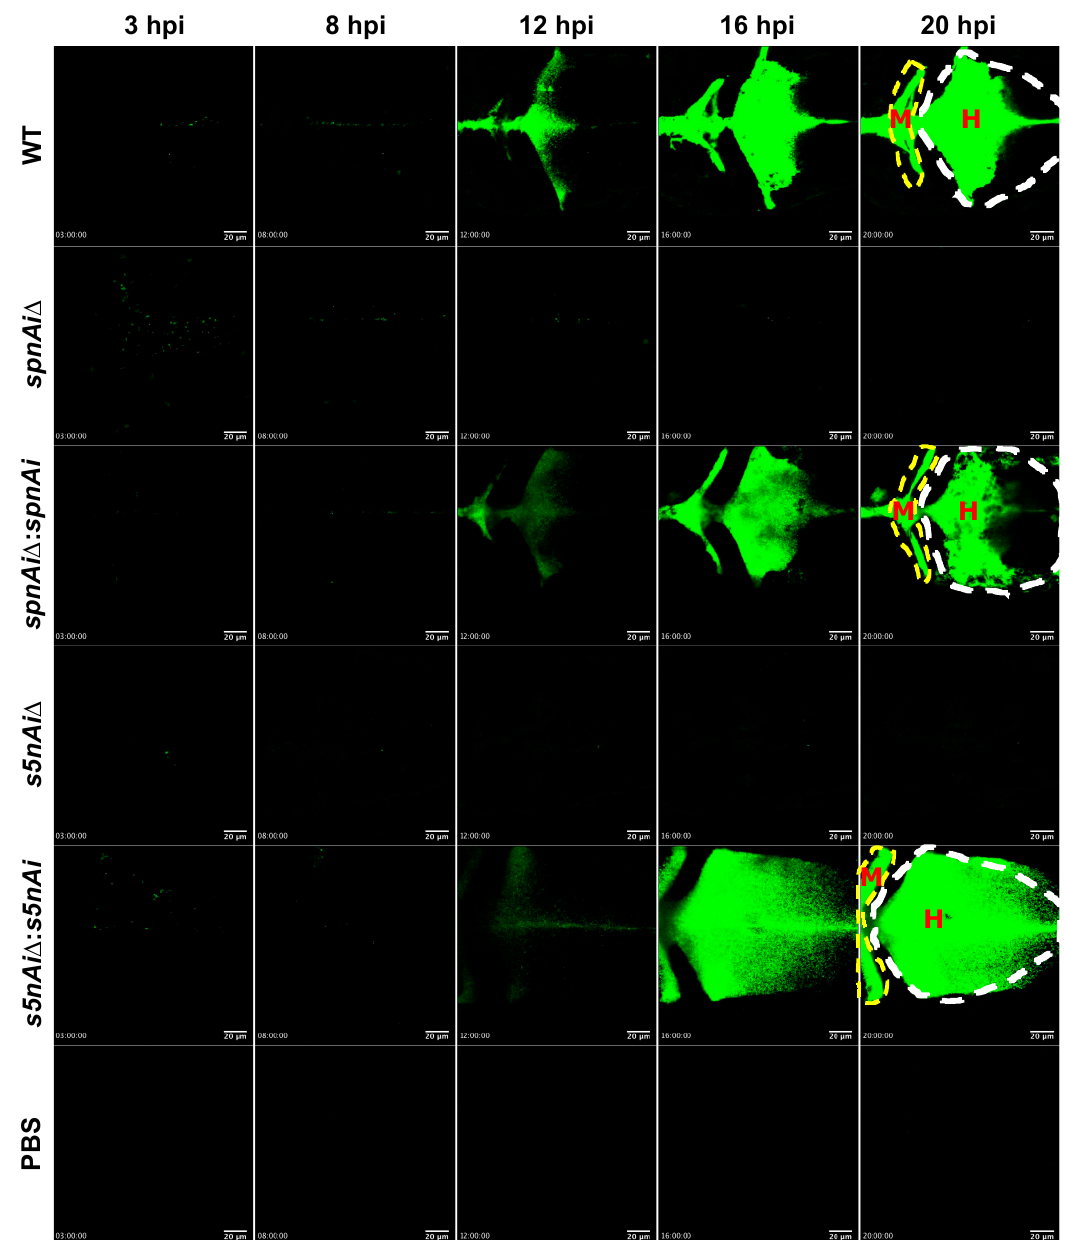
Figure 6. Time-lapse confocal imaging of 2 dpf zebrafish larvae infected with green fluorescent-labeled S. iniae or mutant strains. Confocal microscopy was used to observe the proliferation and dissemination of green fluorescent-labeled S. iniae at the infection site. Larvae (wild-type AB line) were injected with 50 colony-forming units (CFU) of gfpmut2-labelled WT, ∆ spnAi , ∆ spnAi : spnAi , ∆ s5nAi , ∆ s5nAi : s5nAi and sterile PBS at the hindbrain ventricle. Images of the hindbrain ventricle in dorsal view were taken from 3 to 21 hpi using a confocal microscope with a 20 × objective lens. Five frames at 3, 8, 12, 16 and 20 hpi were extracted from the individual movies. H, hindbrain ventricle; M, midbrain ventricle. Scale bar, 20 µ m. In the supplemental materials, see Movies S1. Results are representative of 2 independent experiments.